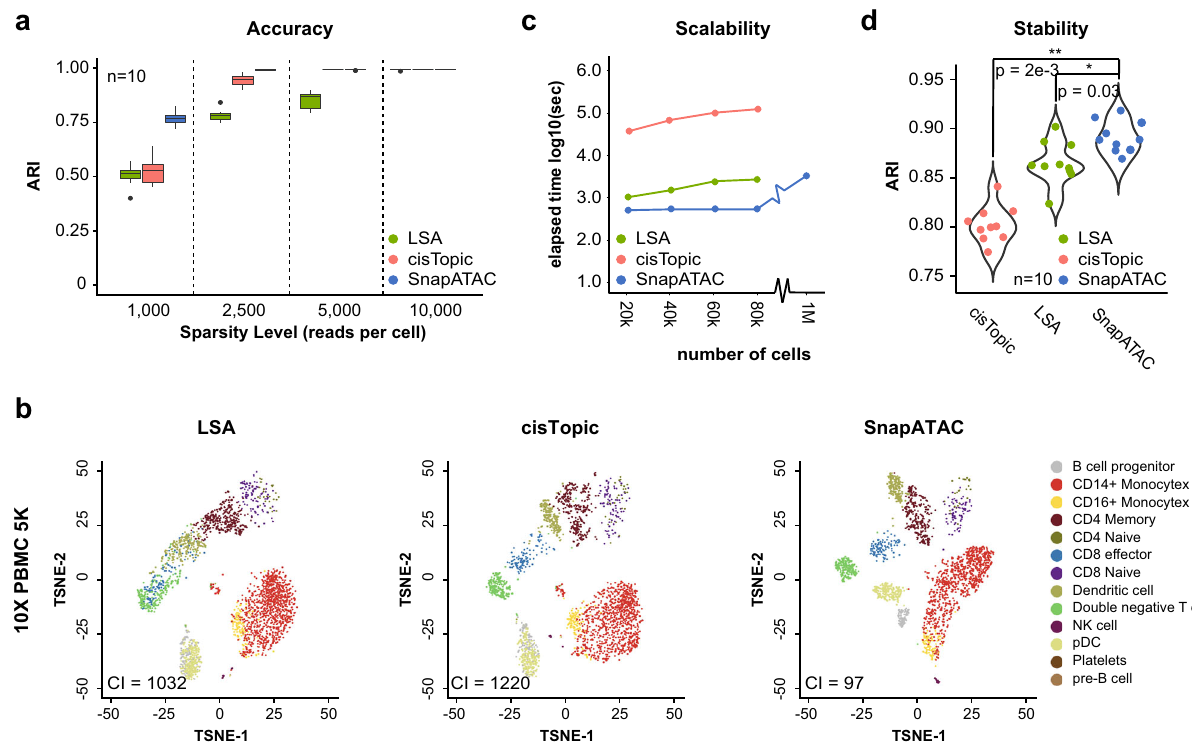
Fig. 4 SnapATAC outperforms current methods in accuracy, sensitivity, scalability, and stability of identifying cell types in complex tissues. a A set of simulated datasets are generated with varying coverage ranging from 1000 to 10,000 reads per cell cells (Methods section). For each coverage, n = 10 random replicates are simulated, and clustering accuracy measurement is based on Adjusted Rank Index (ARI). Data are presented as median values ± 25% percentile. b T-SNE representation of PBMC single-cell ATAC-seq pro fi les analyzed by three methods. The cell-type identi fi cation was predicted by 10X PBMC single-cell RNA-seq (CI = connectivity index; Methods section). c A mouse dataset 8 (data source listed in Supplementary Table 1) is sampled to different number of cells ranging from 20k to 1 M. For each sampling, we compared the CPU running time of different methods for dimensionality reduction. d A set of perturbations ( n = 5) are introduced to the mouse atlas dataset by down sampling to 90% of the original sequencing depth. Clustering outcomes are compared between different downsampled datasets ( n = 10) to estimate the reproducibility. One-tailed t -test was performed to estimate the signi fi cance level between SnapATAC and each of the other methods (* p < 0.05 and ** p <